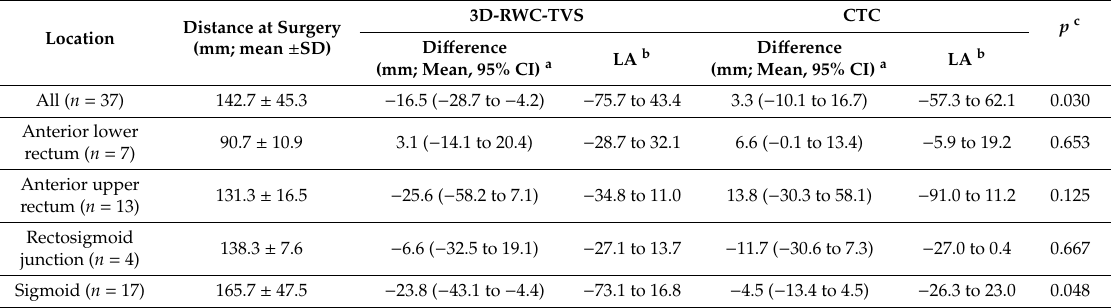
Table 4. Di ff erence between the lower margin of the lowest rectosigmoid nodule and the anal verge estimated by imaging techniques and that measured on